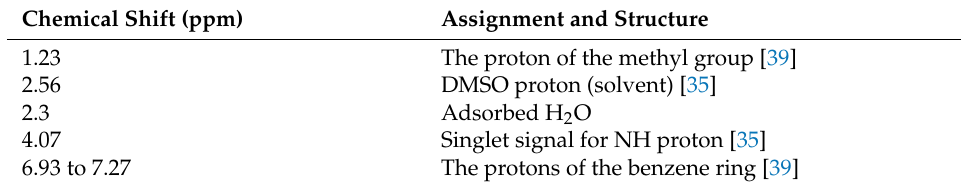
Table 2. The summary of the HNMR analysis.